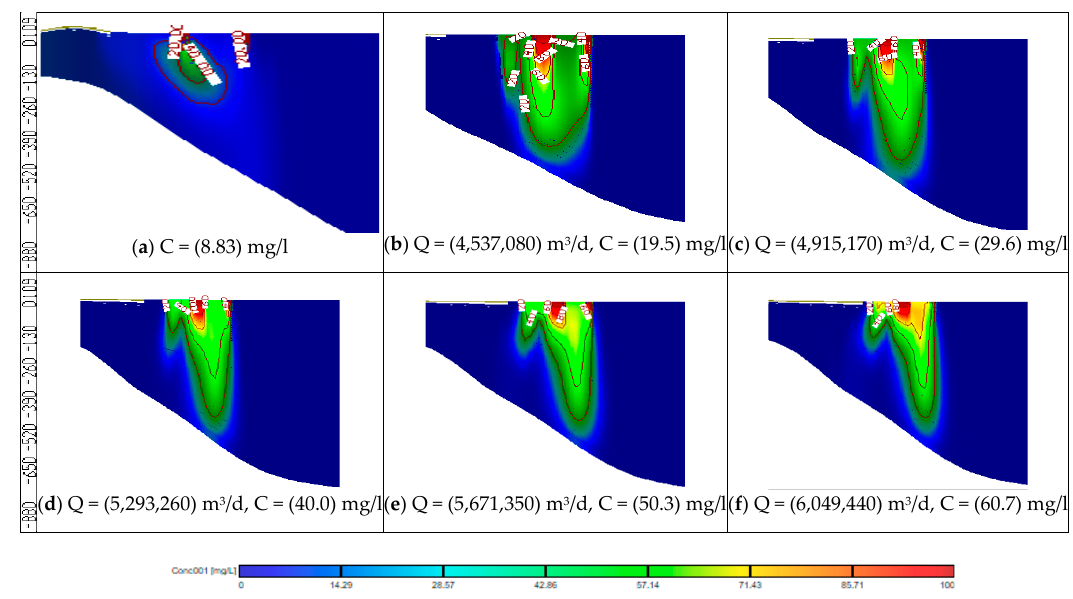
Figure 10. Distribution of COD in the ENDA for different scenarios (7–11) of stage 2.